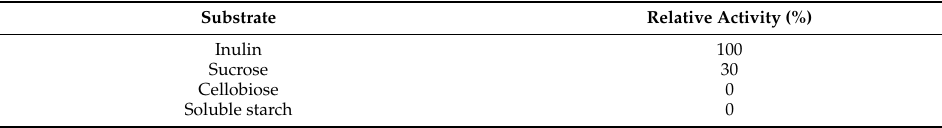
Figure 6. pH stability of the purified inulinase from Rhizopus oryzae NRRL 3563.